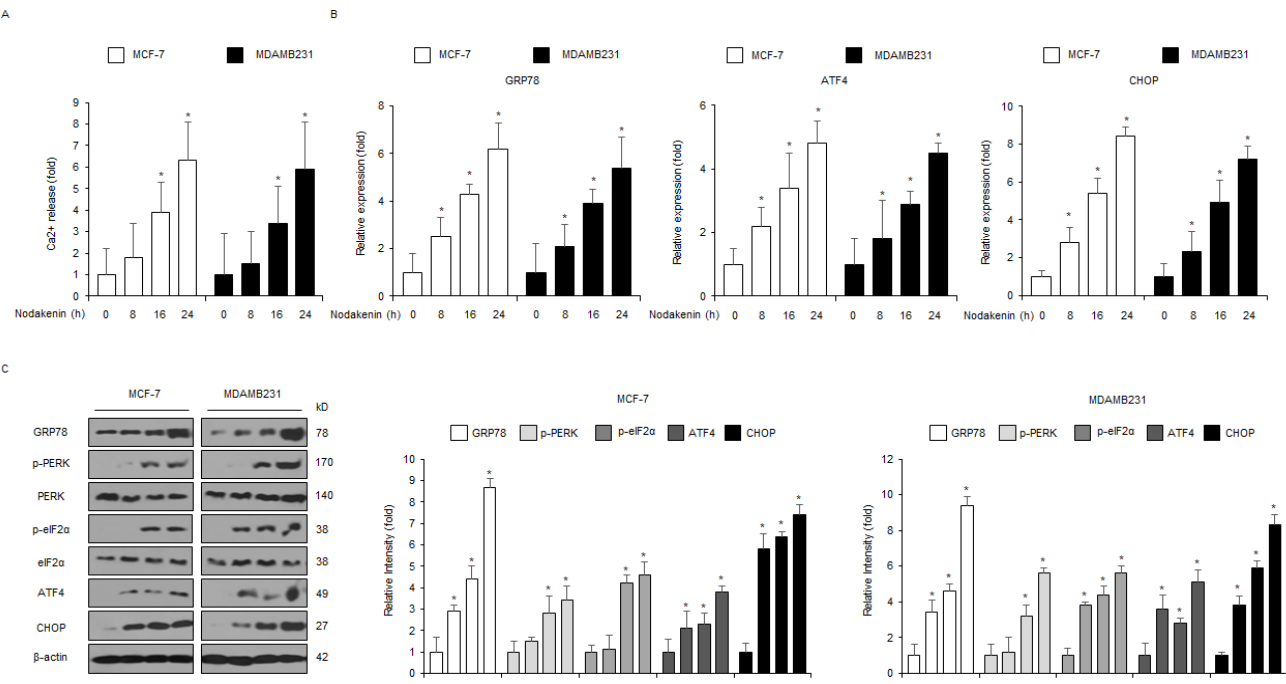
Figure 3. Nodakenin mediates the ER stress response through intracellular Ca 2+ generation. ( A ) MCF-7 and MDAMB231 cells were treated with nodakenin at various time points (0, 8, 16, and 24 h; 40 μM) and then subjected to an intracellular Ca 2+ assay. ( B ) MCF-7 and MDAMB231 cells were treated with nodakenin at various time points (0, 8, 16, and 24 h; 40 μM) and then mRNA expression